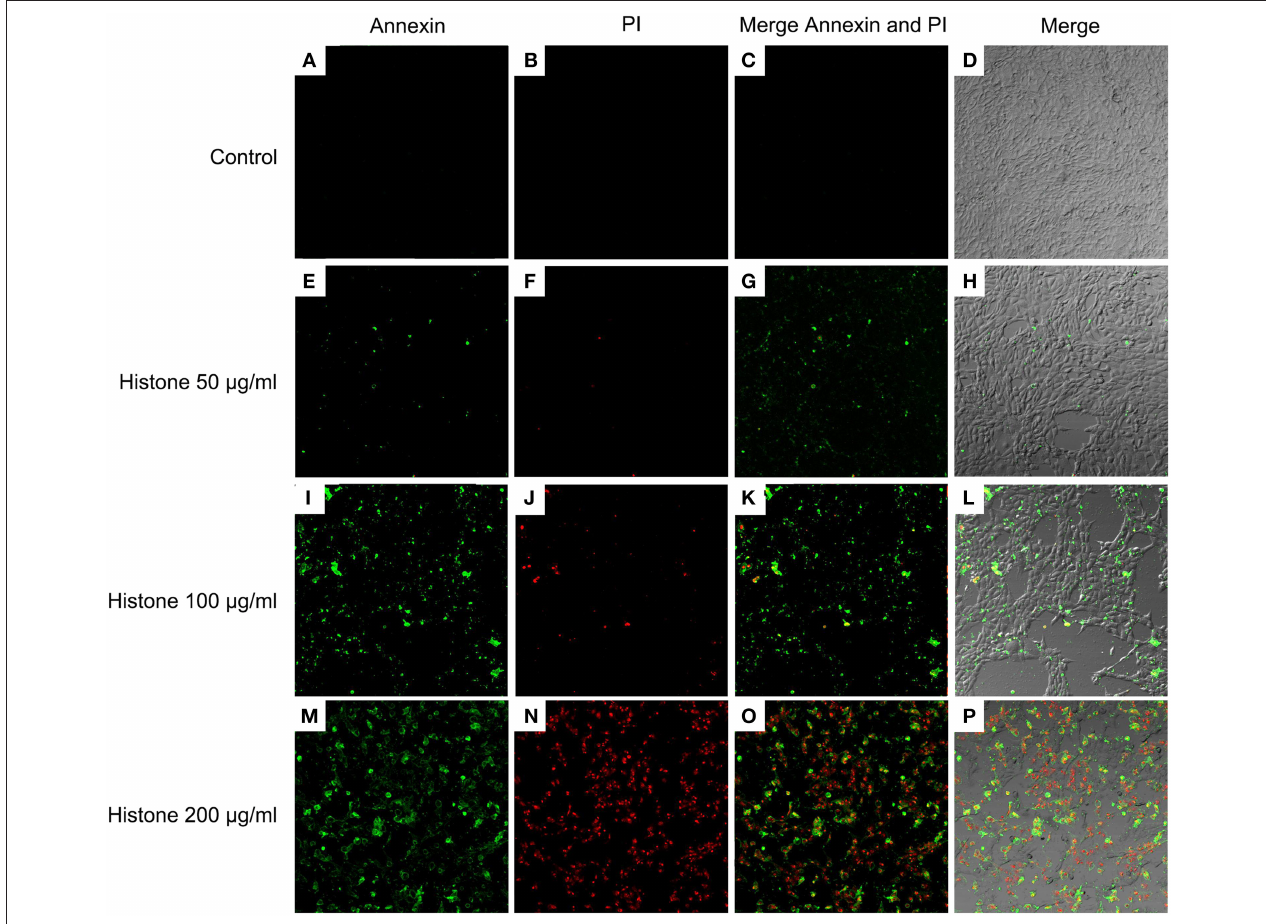
FIGURE 5 | Fluorescence confocal microscopy analyses of histone caused BMECs apoptosis, necrosis, and pyroptosis (400 × ). BMECs were incubated with stimulated histone for 16h. Then, the BMECs were stained FLUOS-Annexin V/PI according to the manufacturer’s protocols and were examined by fluorescence confocal microscopy analyses. Three independent experiments were carried out by fluorescence confocal